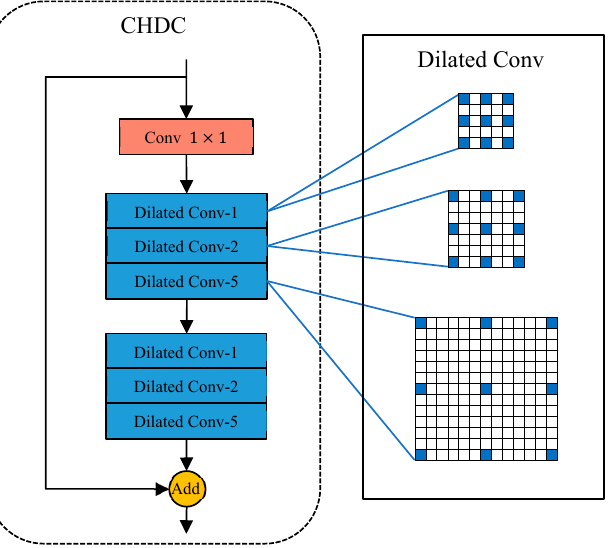
Figure 8. The designed cascaded hybrid dilated convolution module (CHDC), in which dilated conv-1, 2, and 5 are dilated convolutions with dilated rates of 1, 2, and 5, respectively, as shown on the right.